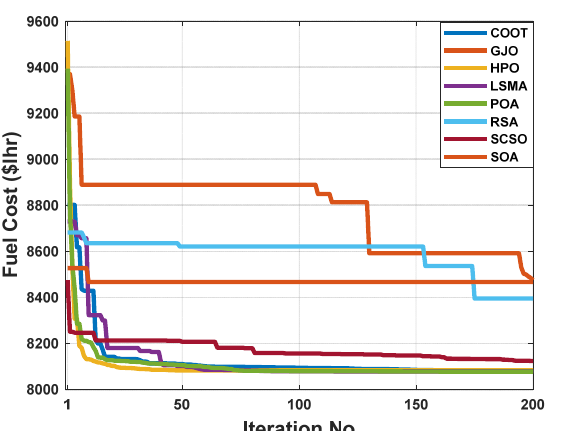
Figure 3. The convergence characteristics of POA and other compared algorithms for case 1 in a standard IEEE 14-bus test system.